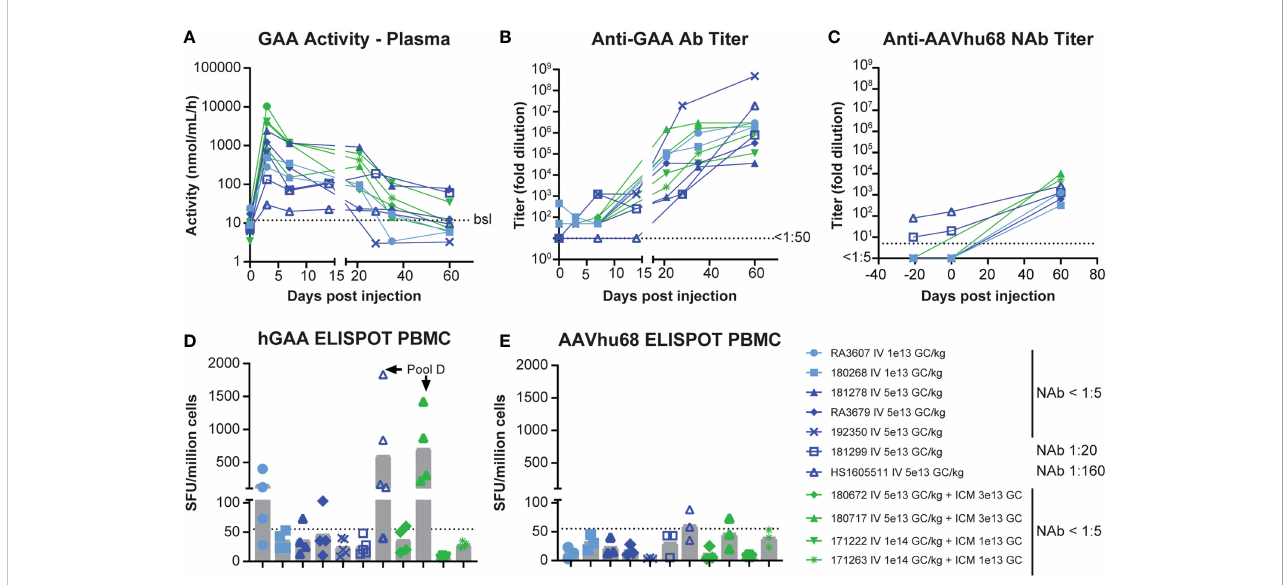
FIGURE 1 Pharmacology of AAVhu68.hGAA and immune responses. (A) GAA enzyme activity in plasma, (B) anti-hGAA total antibody titers, and (C) anti-AAVhu68 NAb titers. Each data point represents an individual animal and timepoint. Nine animals had a negative AAVhu68 NAb baseline while two had pre-existing NAb titers of 1:10 to 1:80 at screening and 1:20 to 1:160 at day 0 pre-dosing. Peripheral blood mononuclear cell (PBMC) ELISPOT responses to (D) hGAA peptide pools and (E) AAVhu68 peptide pools from eleven rhesus macaques that received IV AAVhu68.CAG.vIGF2.hGAA vectors at 1x10 13 GC/kg or 5x10 13 GC/kg or combined IV and ICM at 5x10 13 GC/kg and 3x10 13 GC, or at 1x10 14 GC/kg and 1x10 13 GC, respectively. Each data point represents a separate peptide pool from an individual